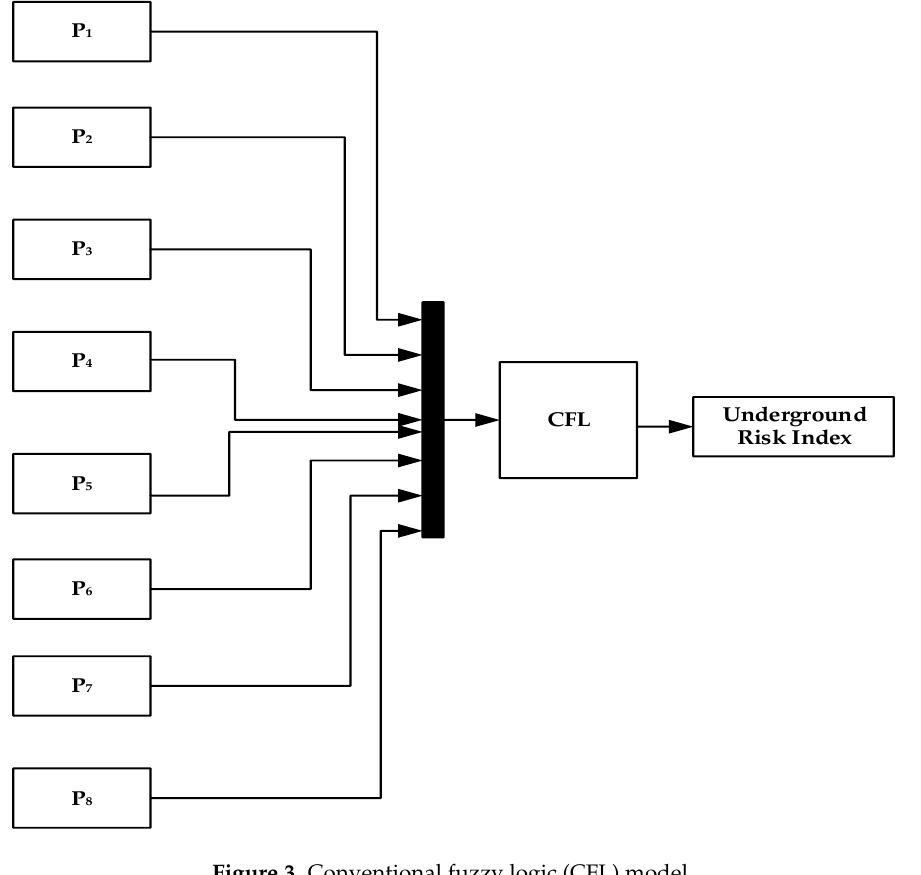
Figure 4 for the WPR F fuzzy logic. Similarly, the Mamdani fuzzy logic for SPR F , MSR F , and GR F has been used, having the same characteristics as in Figure 4.